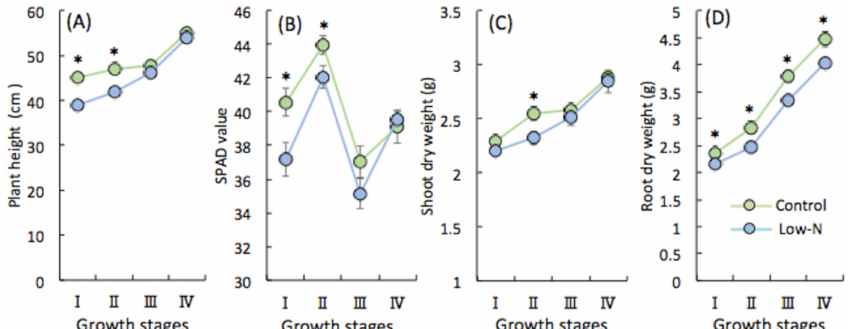
Figure 1. ( A ) Plant height; ( B ) SPAD value; ( C ) shoot dry weight; ( D ) root dry weight. I, II, III, and IV refer to before and after topdressing at tiller initiation and early panicle formation stages. Each point represents the mean value, error bars indicate mean ± SD of 5 replicates. * Significant di ff erence ( p < 0.05, Student’s t -test).